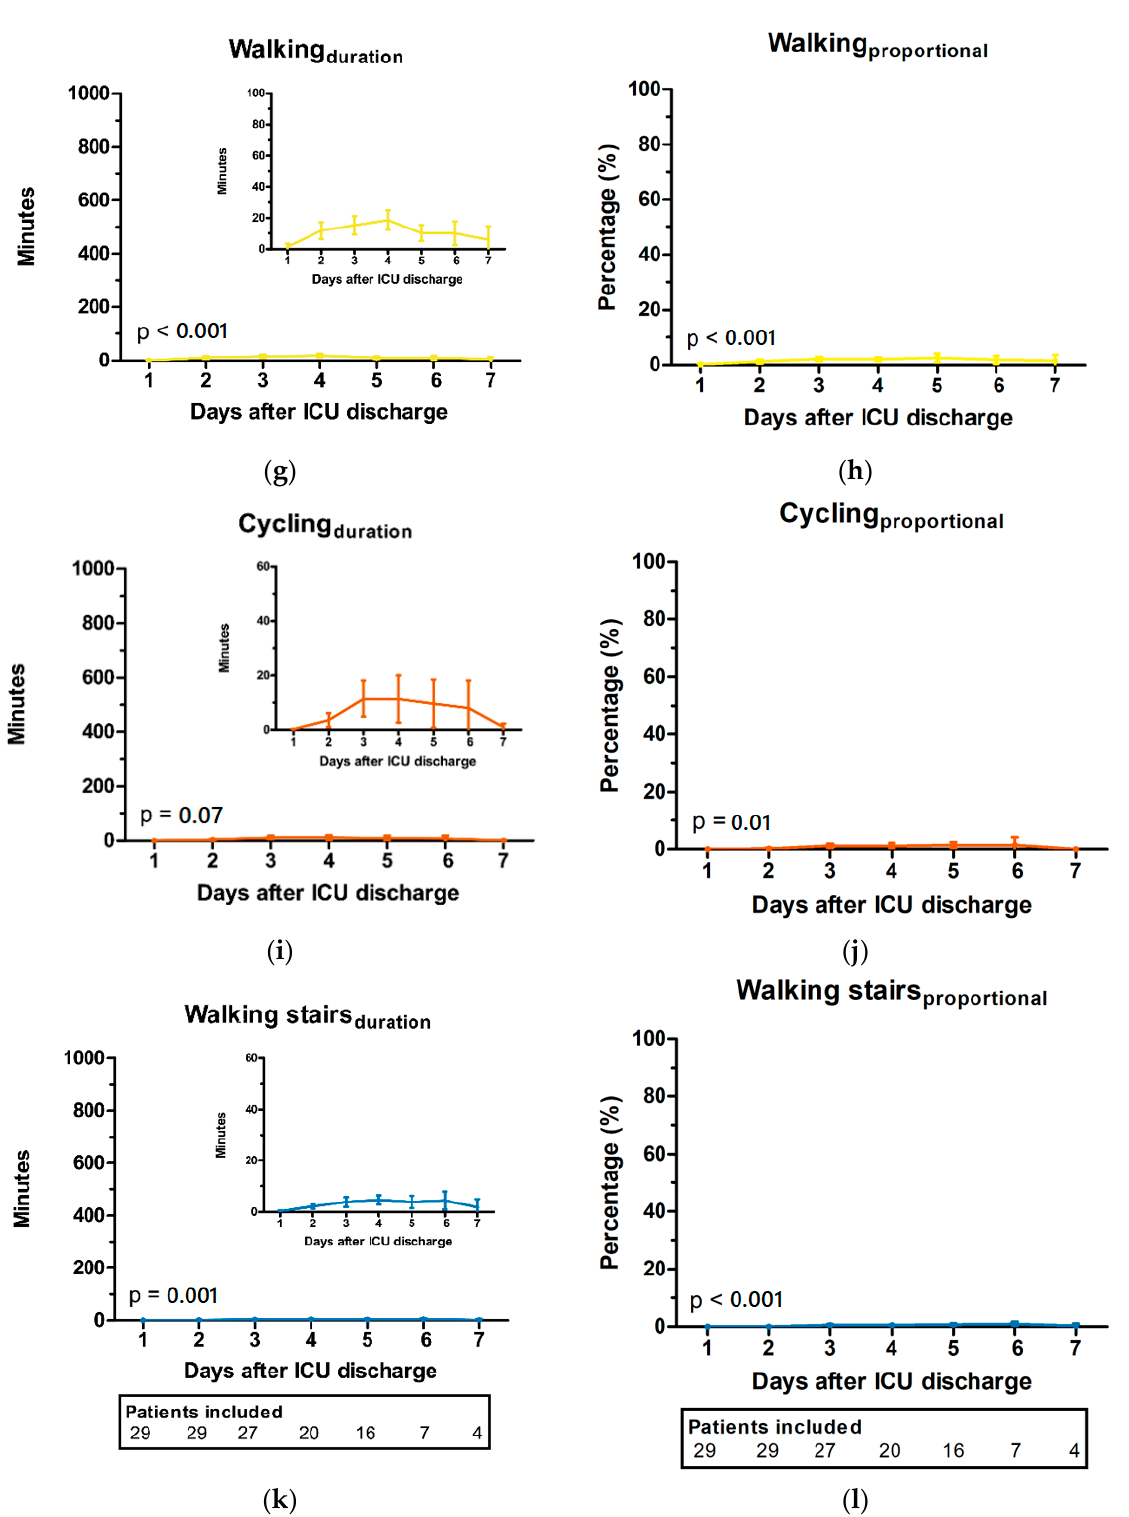
Figure 3. Patient activities at the cardio-thoracic surgery ward as labelled with the average time spent on each activity between 7 a.m. and 11 p.m. on the left panels, and the relative time as percentage on the right panels: ( a , b ) lying in bed; ( c , d ) sitting in a chair; ( e , f ) standing; ( g , h ) walking; ( i , j ) cycling; ( k , l ) walking the stairs. Lines represent the mean with 95% confidence interval and the p -values depict the effect of time (days) on each activity. Fixed axes are used for comparison with additional inlays to show details.